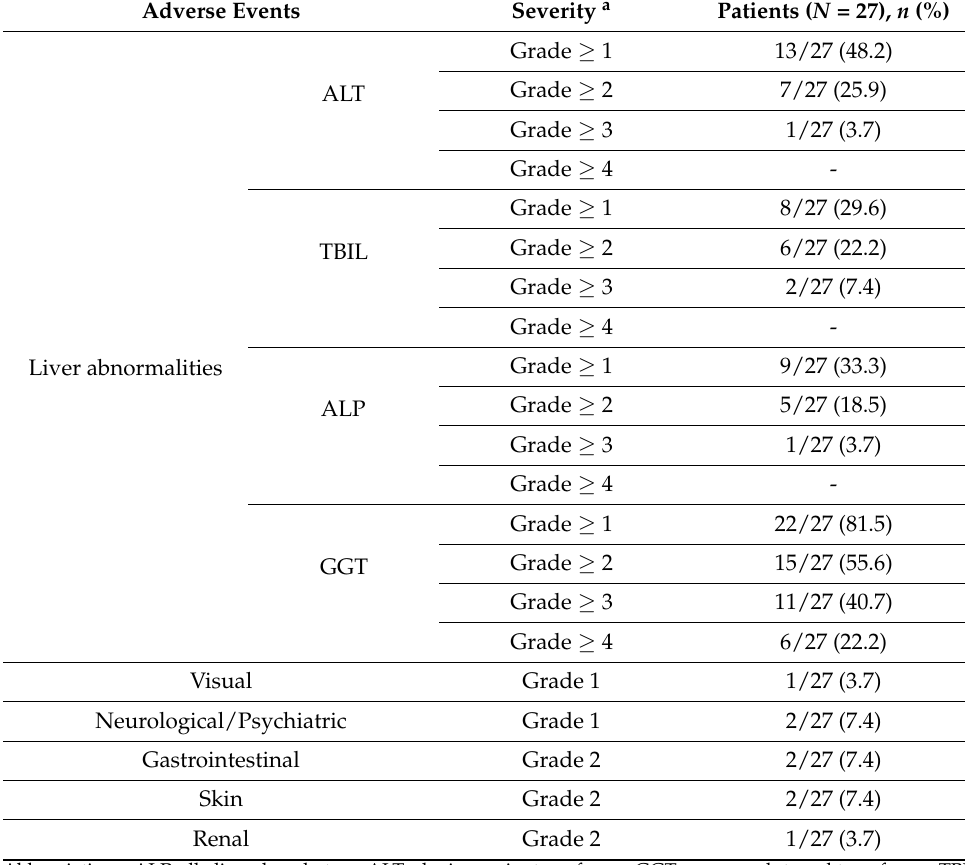
Table 6. Adverse